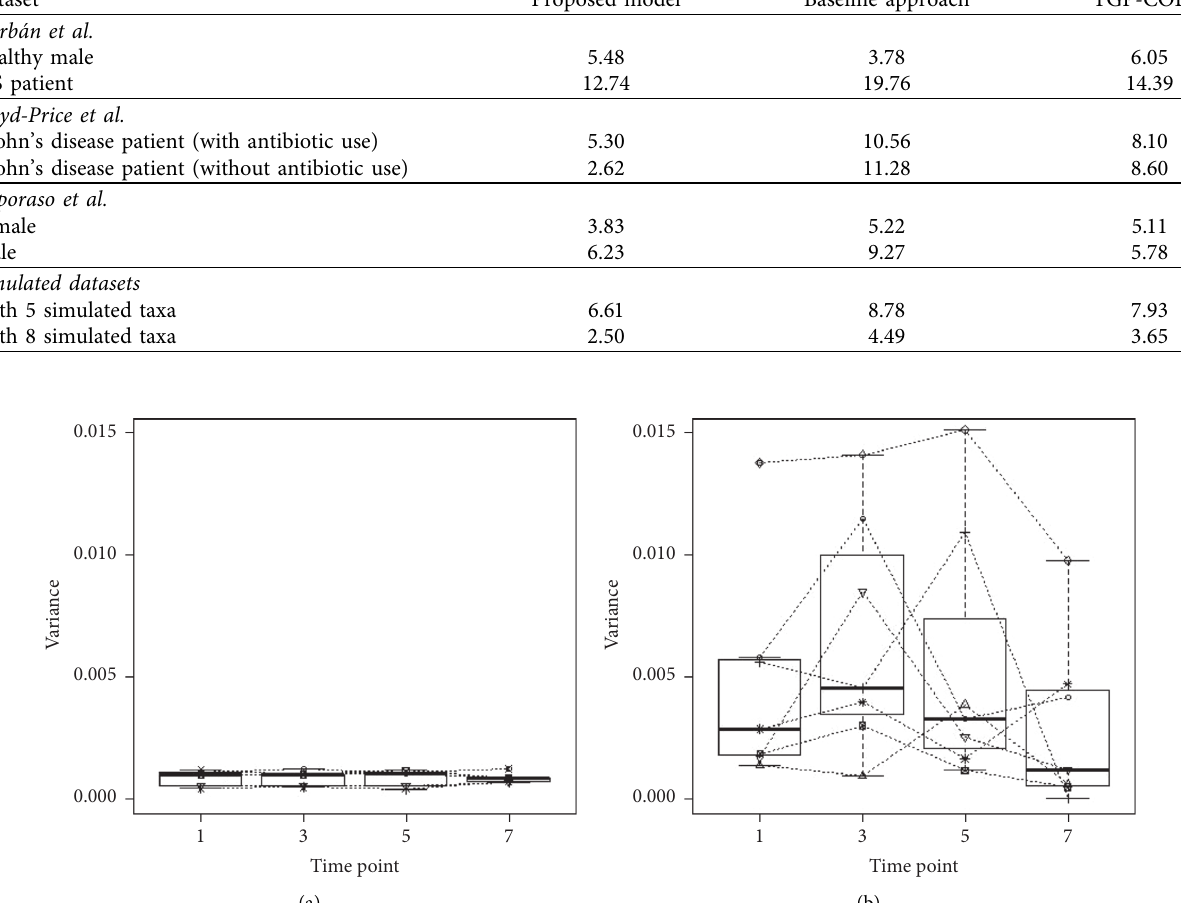
Figure 4: Variance time series for the healthy male and the female IBS patient. The families have been represented by the following markers: Bacteroidaceae ( ∘ ), Porphyromonadaceae ( ◇ ), Rikenellaceae ( ▽ ), Ruminococcaceae ( ⊠ ), Erysipelotrichaceae ( △ ), Lachnospiraceae (+), and Other ( × ). (a) Healthy patient. (b) Unhealthy